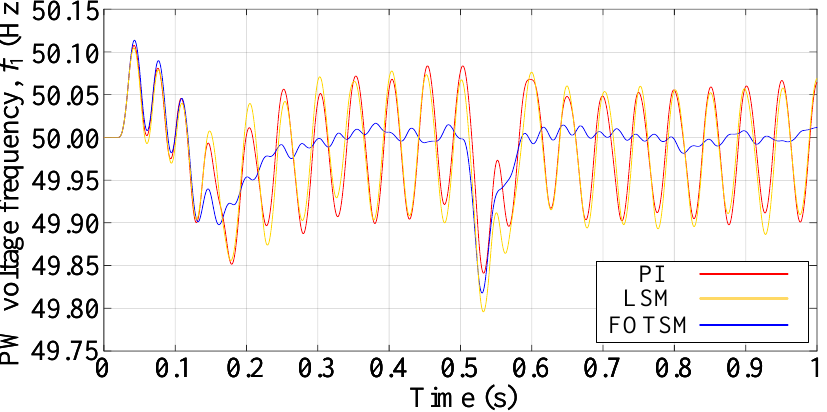
Figure 10. The PW voltage frequency responses under PI, LSM, and FOTSM during the load adding